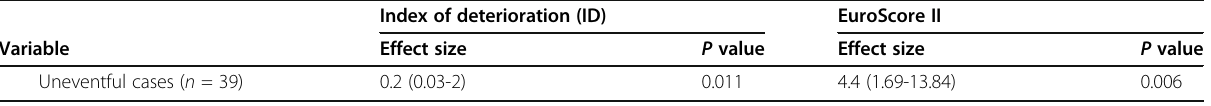
Table 3 Index of deterioration versus EuroScore values (Continued)